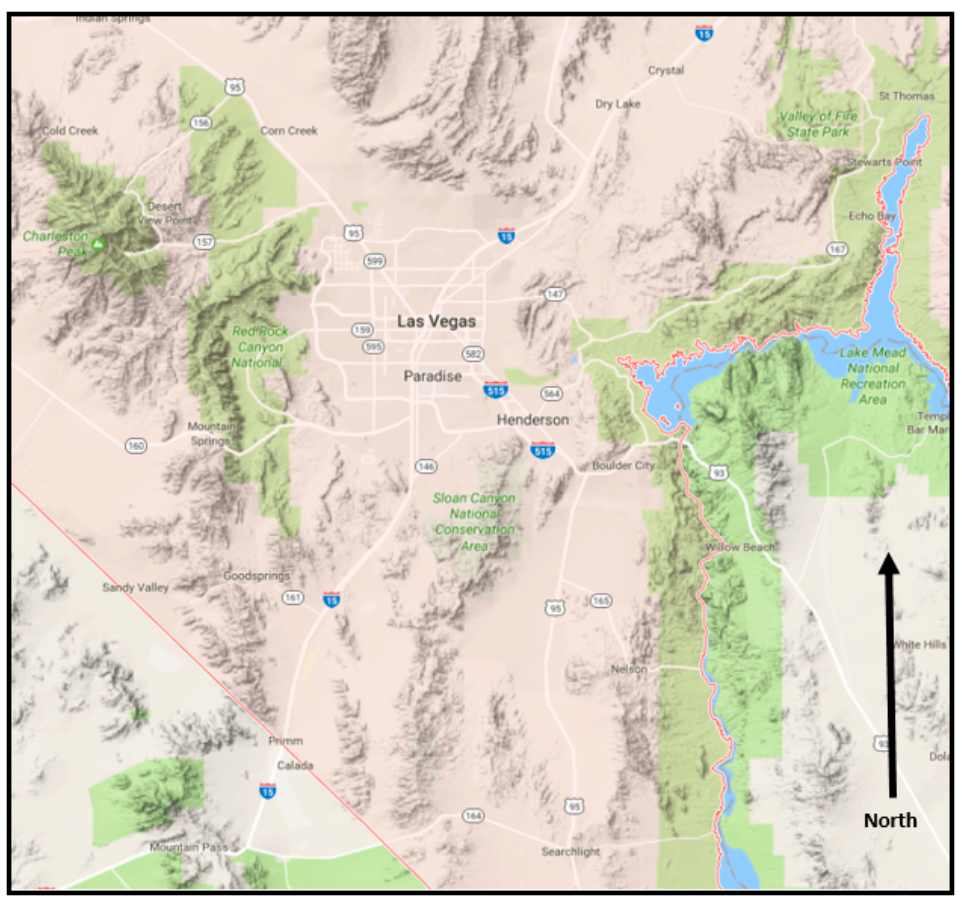
Figure 1. Southern Nevada and the Las Vegas Valley showing north-south trending mountain ranges (Google maps).